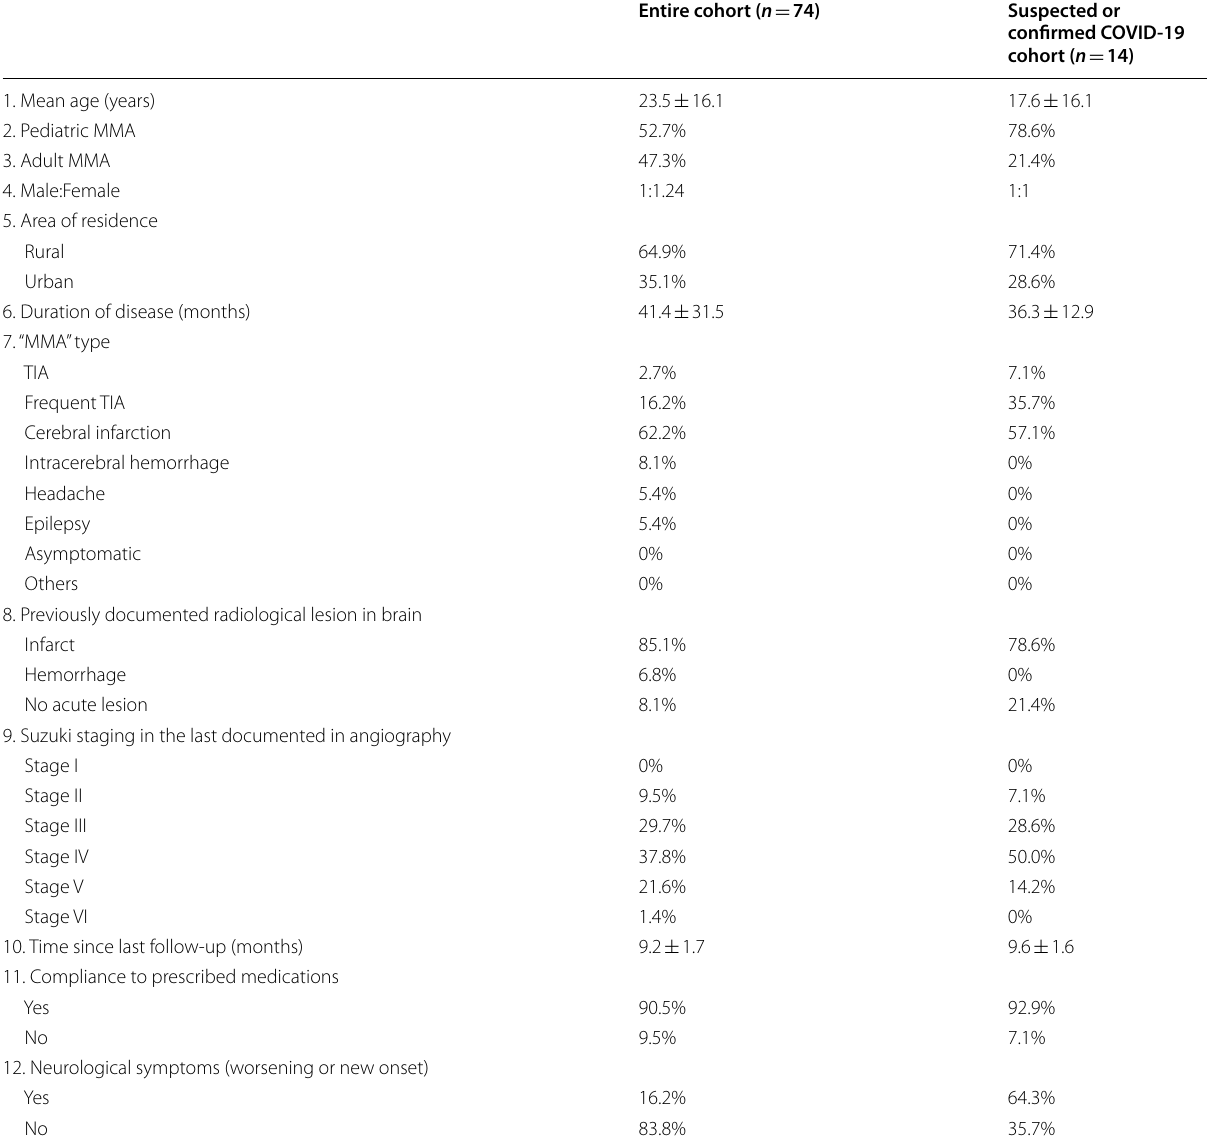
Table 1 Demographic, clinical, radiological and follow-up of entire cohort and suspected or confimed COVID-19